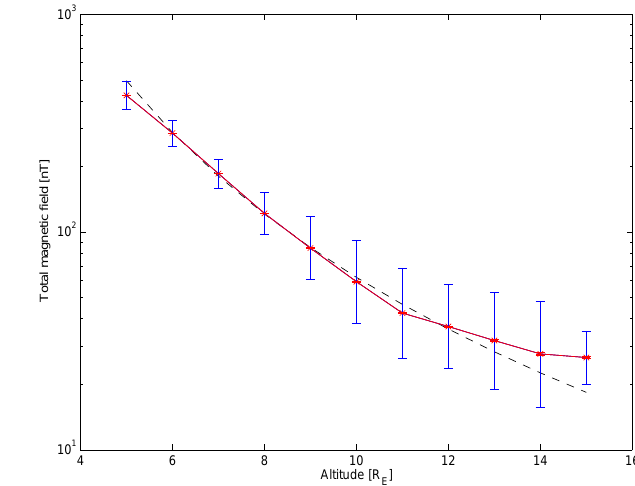
Fig. 5. Profile of the perpendicular temperature versus altitude. The blue error bars show the standard deviation for the logarithmic value. The black dots are the calculated perpendicular temperatures from the test particle calculation.